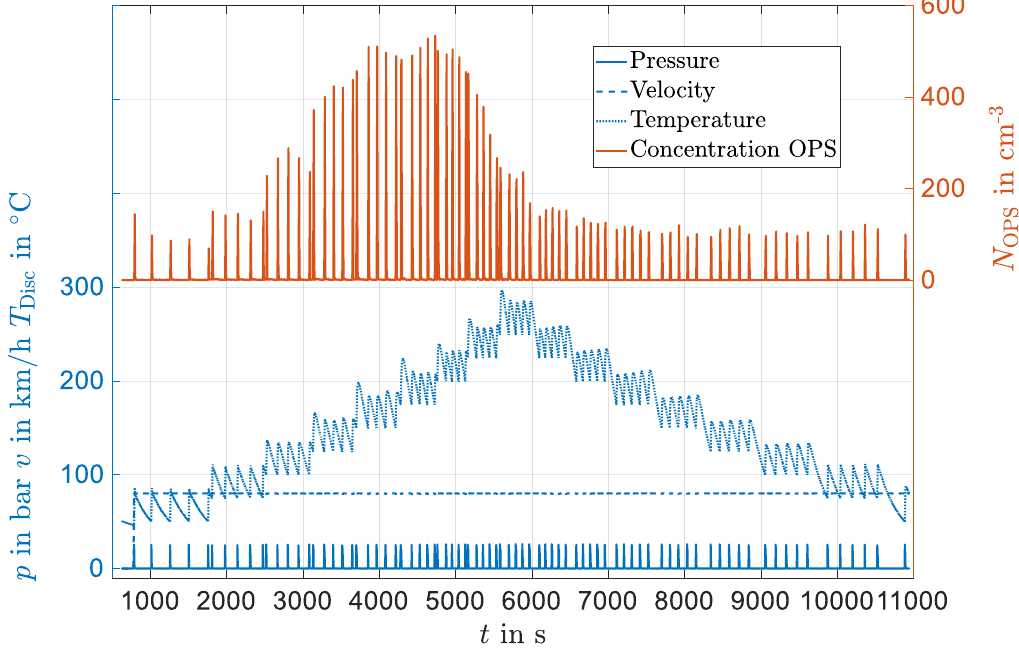
Figure 7. Time series of brake pressure p , velocity v , temperature T , and OPS-concentration N of the PM 10 relevant particles emitted by the pads with an organic binder. Although the shape of the temperature triangle is symmetric, the system’s answer in the shape of the OPS-concentration is asymmetric with a shift to the ascending side of the triangle, which indicates a change in the temperature dependency of the emission behavior. The aerosol was diluted by a factor of 18.8 before it was led to the OPS.